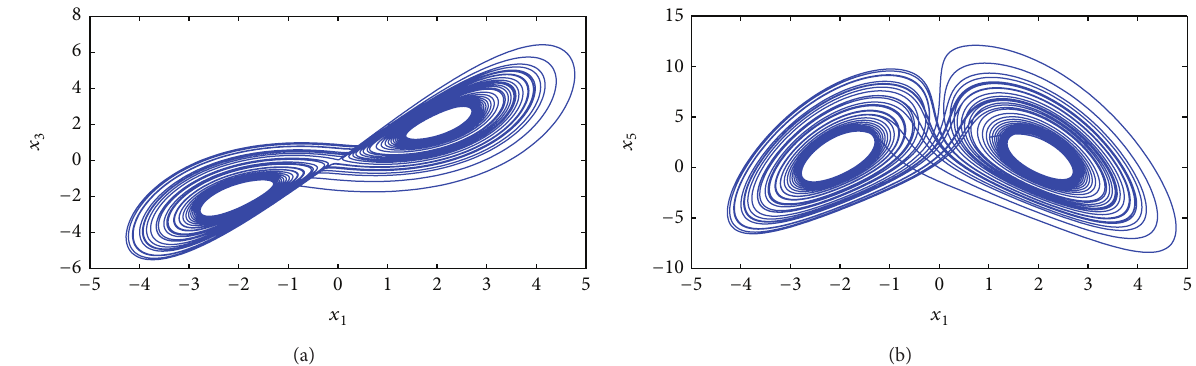
Figure 1: The chaotic attractors of the system (14) projected onto different phase plane (a) 𝑥 1 - 𝑥 3 phase plane and (b) the chaotic attractor projected onto 𝑥 1 - 𝑥 5 phase